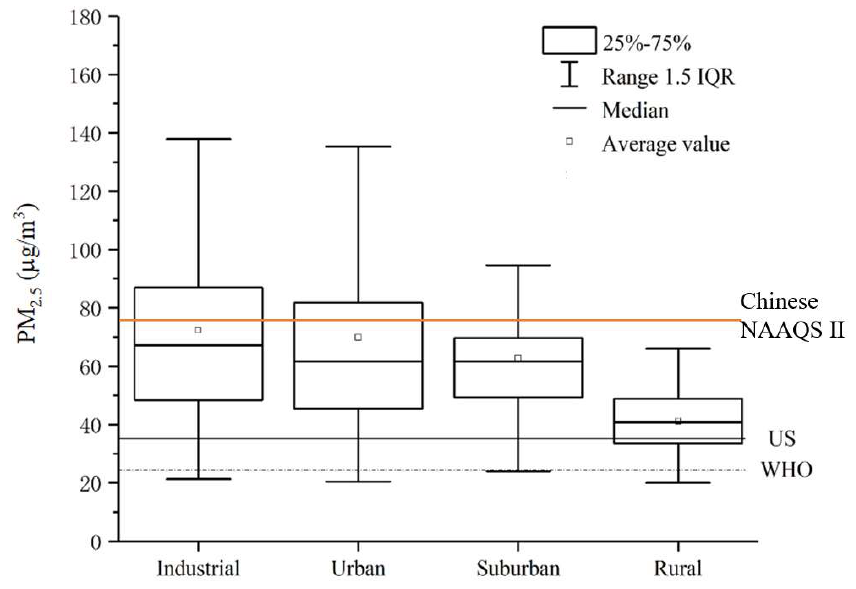
Figure 2. The concentrations of atmospheric particles with an aerodynamic diameter less than or equal to 2.5 µ m (PM 2.5 ) in industrial, urban, suburban, and rural areas of Nanjing city during 2016 compared with typical international air quality guideline values (24 h).